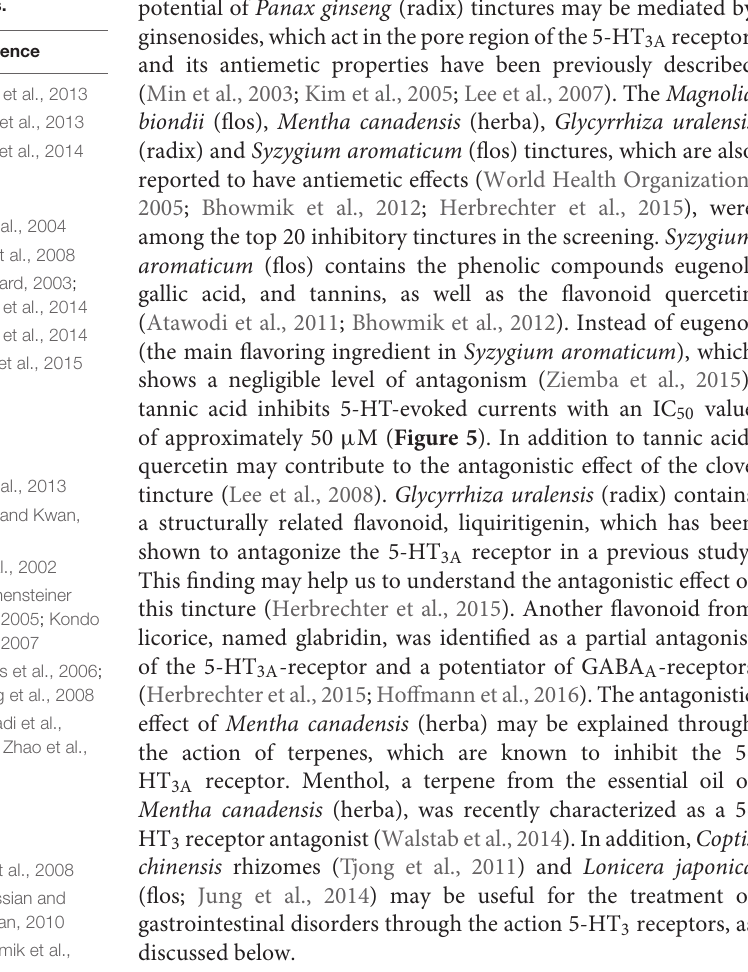
TABLE 1 | Investigated ingredients and their respective